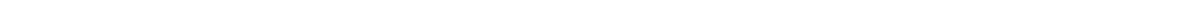
Fig. 3c. Representative histograms of EdU incorporation evaluated 24 h after injection and graph of combined results from two litters are shown in e . Horizontal line represents mean ( n = 3 – 5 mice). f Proposed model for the mechanism underlying post-natal Vegfr3 loss-induced lymphatic vessel hyperplasia in the ear. Incomplete deletion of Vegfr3 promotes selection of non-targeted VEGFR3 + cells to the tips of vessel sprouts and their excessive proliferation and vascular anastomosis. Proliferation of non-targeted VEGFR3 + cells is sustained by continuous induction of new VEGFR3 - neighbors through repeated Tamoxifen administrations during a critical post-natal period of 2 weeks. ** P < 0.01, *** P < 0.001. Two-tailed unpaired Student ’ s t test ( e ). ns: not signi fi